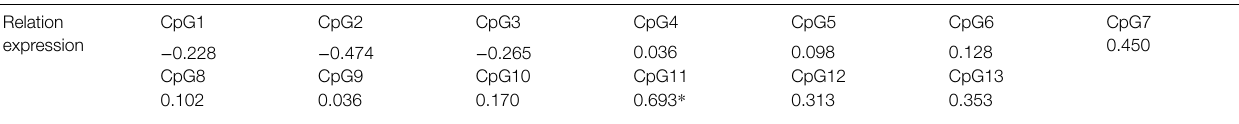
TABLE 5 | Correlation between mRNA expression of WNT2 gene and CpG site. Relation